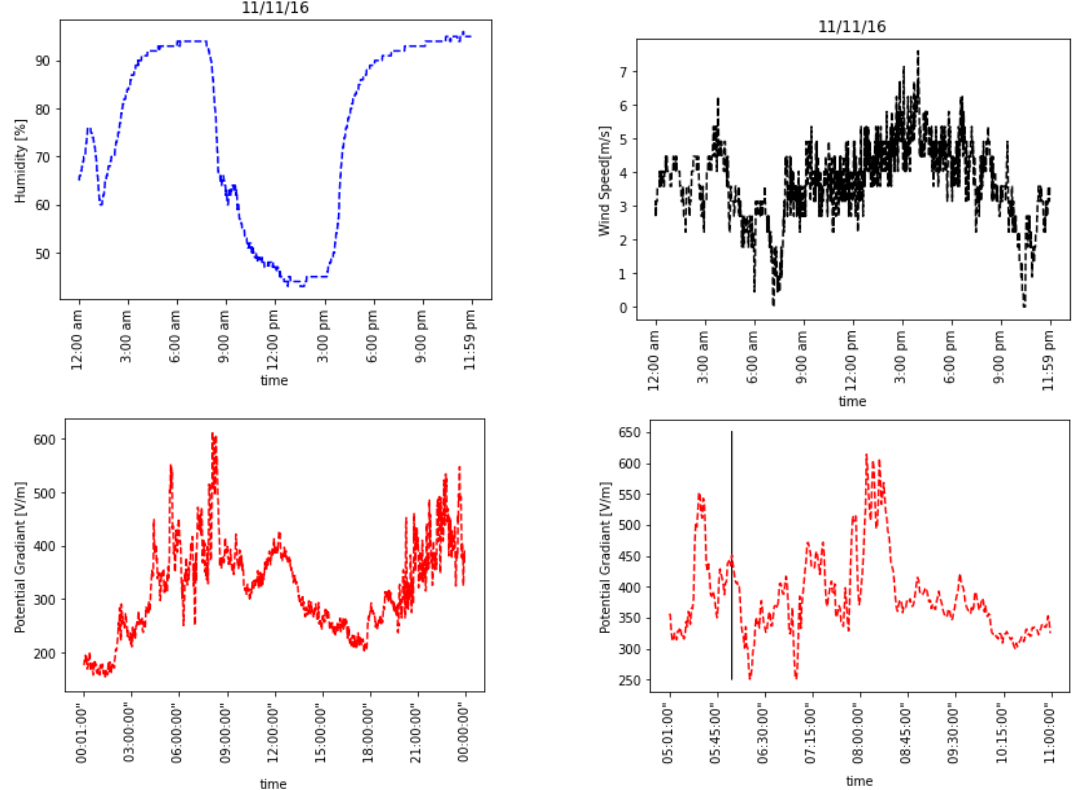
Figure 6. Data for the 11 November 2016 fog case study. Hourly values of relative humidity ( top left ), wind speed ( top right ), daily PG ( bottom left ), and hourly 5:00–11:00 PG ( bottom right ). The vertical black line is the sunrise time 06:03 LT.